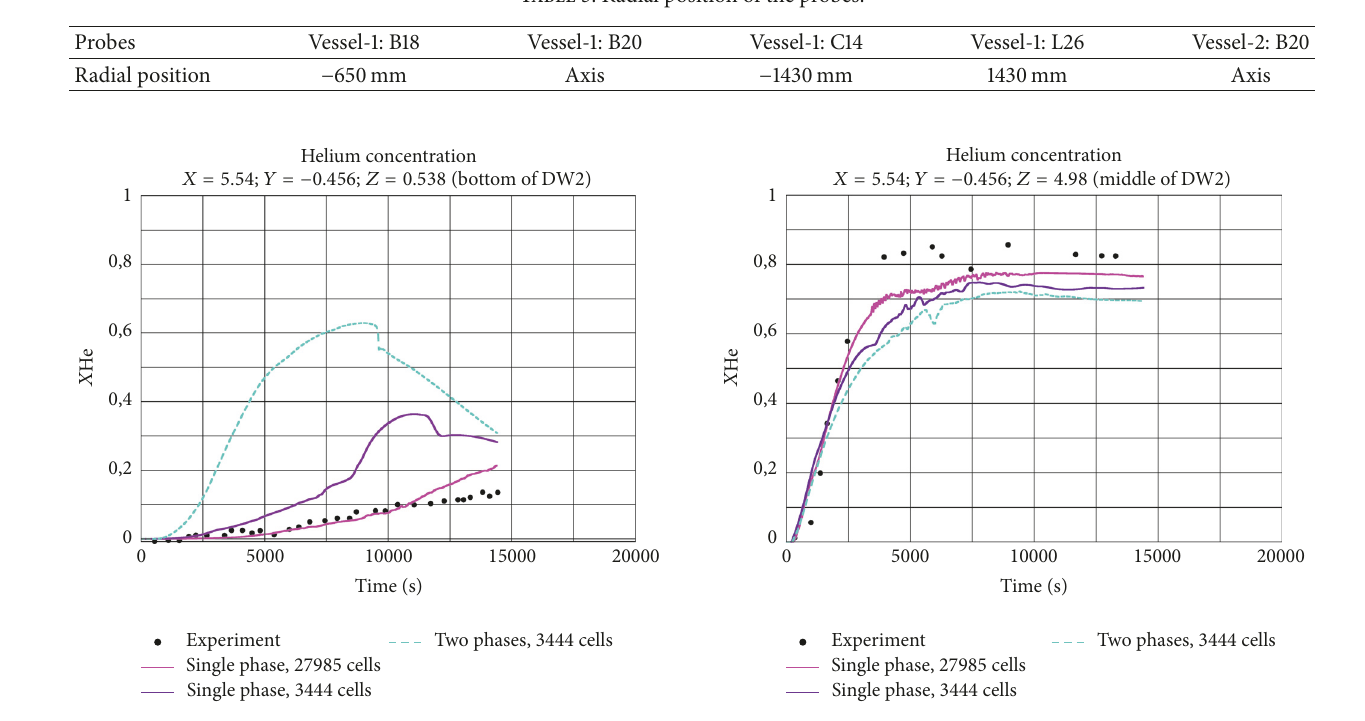
Figure 11: Helium concentration at the bottom of DW2.